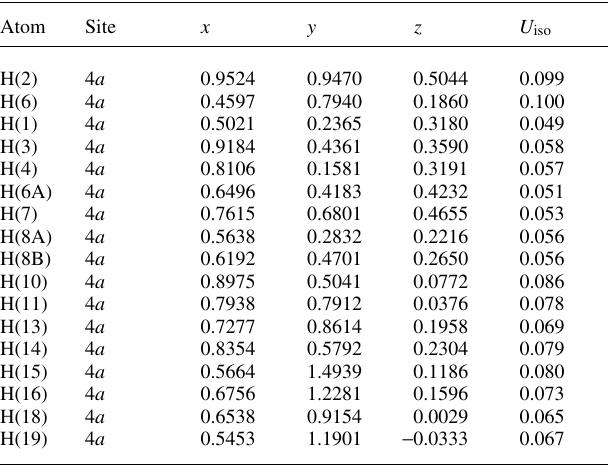
Table 2. Atomic coordinates and displacement parameters (in Å 2 )